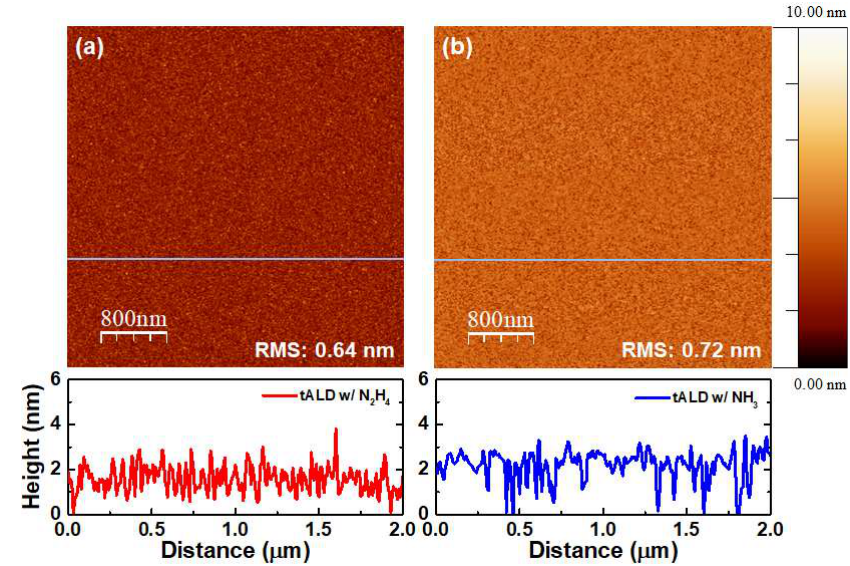
Figure 7. Surface roughness of AlN thin films deposited using ( a ) hydrazine (N 2 H 4 ) and ( b ) ammonia (NH 3 ), as the nitrogen source. Root-mean-square (RMS) values of AlN thin films deposited using N 2 H 4 and NH 3 were 0.64 and 0.72 nm, respectively.